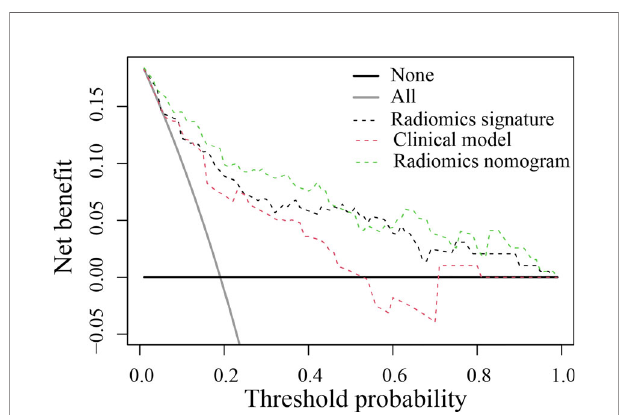
FIGURE 5 | Decision curve analysis for the developed prediction models. The y-axis represents the net bene fi t. The x-axis represents the threshold probability. The green line represents the radiomics nomogram. The red line represents the clinical model. The black line represents the radiomics signature. The gray line represents the assumption that all patients were included in the recurrence group (RG). The black line represents the assumption that no patients were included in the RG. The threshold probability was where the expected bene fi t of the treatment was equal to the expected bene fi t of avoiding treatment. The decision curve in the validation cohort showed that the radiomics nomogram added more net bene fi t than the clinical model within the range of